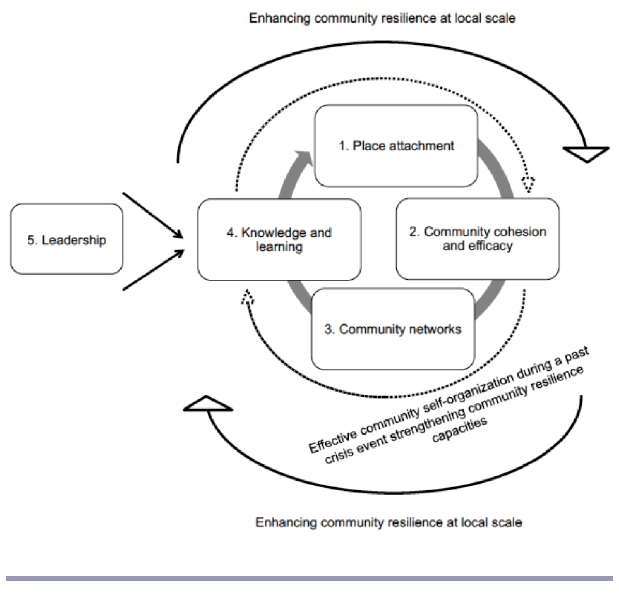
live, community agency can emerge as the capacity of local people to unite and potentially act is increased (Theodori 2004, Brennan et al. 2005). Fig. 2. Prioritization of community resilience capacities from resident perceptions in Boscastle on a scale of 1 to 5 (number 1 represents the most important capacity for community resilience, and number 5 represents the least important).